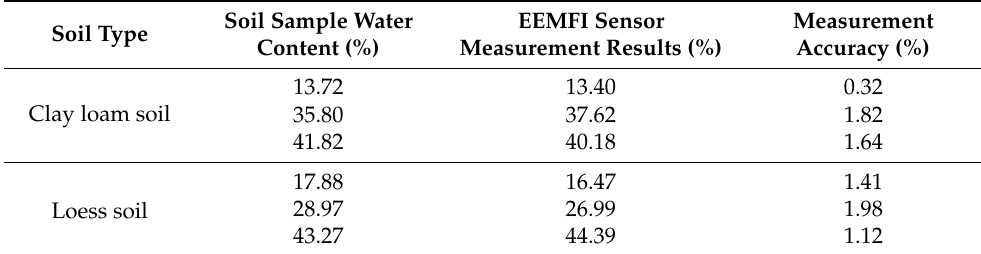
Table 5. EEMFI sensor measurement